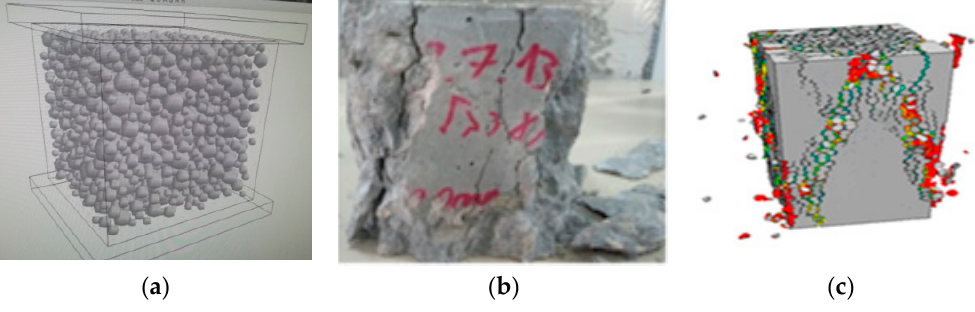
Figure 15. ( a ) Patical size distribution of the LDPM; ( b ) experimental crack pattern for the uniaxial test; and ( c ) crack pattern obtained by the LDPM simulation.